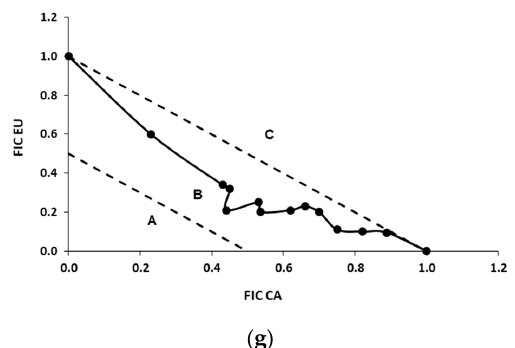
Figure 3. Isobolograms of combinations of EOs (CLEO, CBEO, and CLOEO) and pure compounds (VA and CA) against E. coli O157:H7. ( a ) CLEO/CLOEO; ( b ) CBEO/CLEO; ( c ) CBEO/CLOEO; ( d ) CLOEO/VA; ( e ) CLEO/VA; ( f ) CBEO/VA; ( g ) EU/CA. See Figure 1 for the interpretation of the isobolograms.